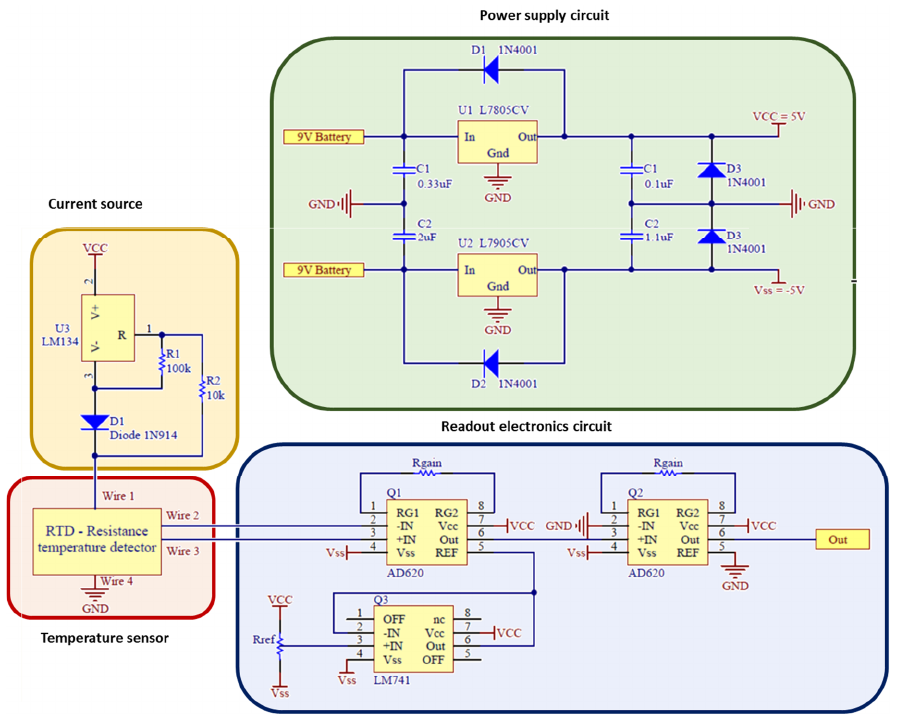
Figure 8. Schematic of the readout and control electronics for temperature microsensors.